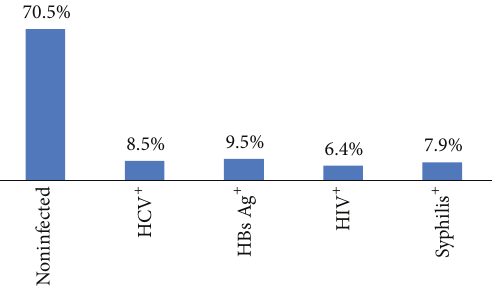
Figure 1: Distribution of blood borne pathogens infection among blood donors at Wolaita Sodo Teaching Referral Hospital 2015.